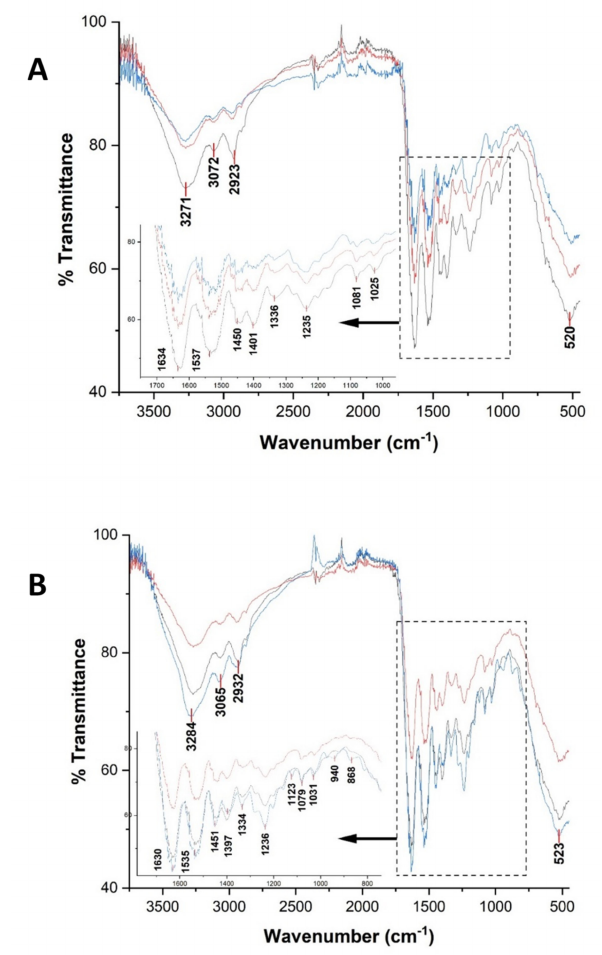
Figure 5. IR spectra of ( A ) G 10 N 10 , G 10 C 20 N 10 , and G 10 C 80 N 10 , and of ( B ) G 10 N 10 , G 10 D 20 N 10 , and G 10 D 80 N 10 . When the concentration of phenolic compound is high (80 mM), a difference is observed between the spectra, which corresponds only to the presence of the phenolic